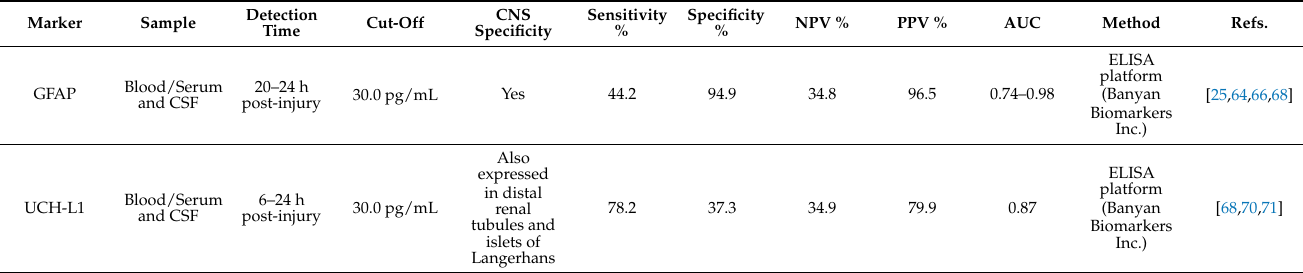
Table 3. Analytical features of each TBI